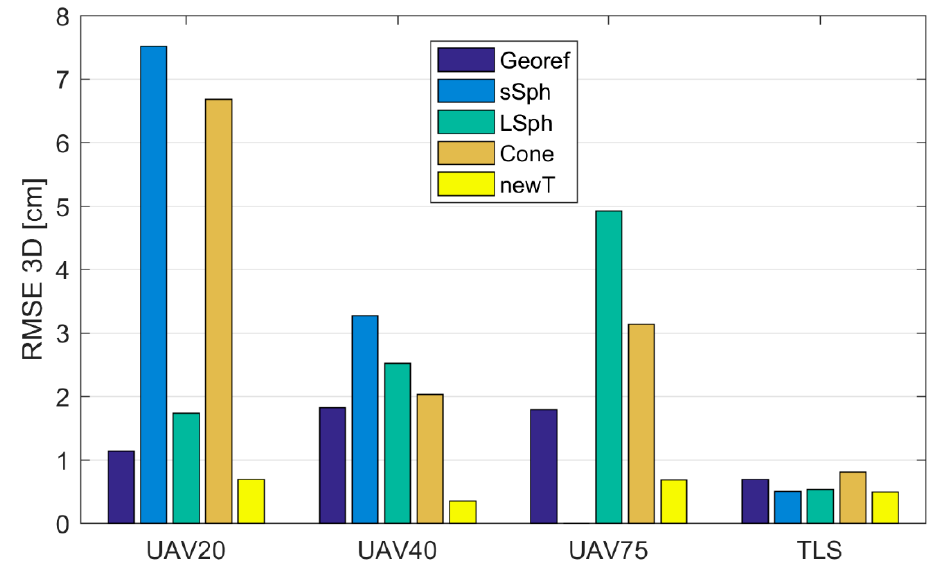
Figure 17. The RMSE 3 D of the check points following the UAV and TLS point cloud registration into Figure 17. The 𝑅𝑀𝑆𝐸 (cid:2871)(cid:3005) of the check points following the UAV and TLS point cloud registration into the referential measurements performed with the referential measurements performed with MS50.